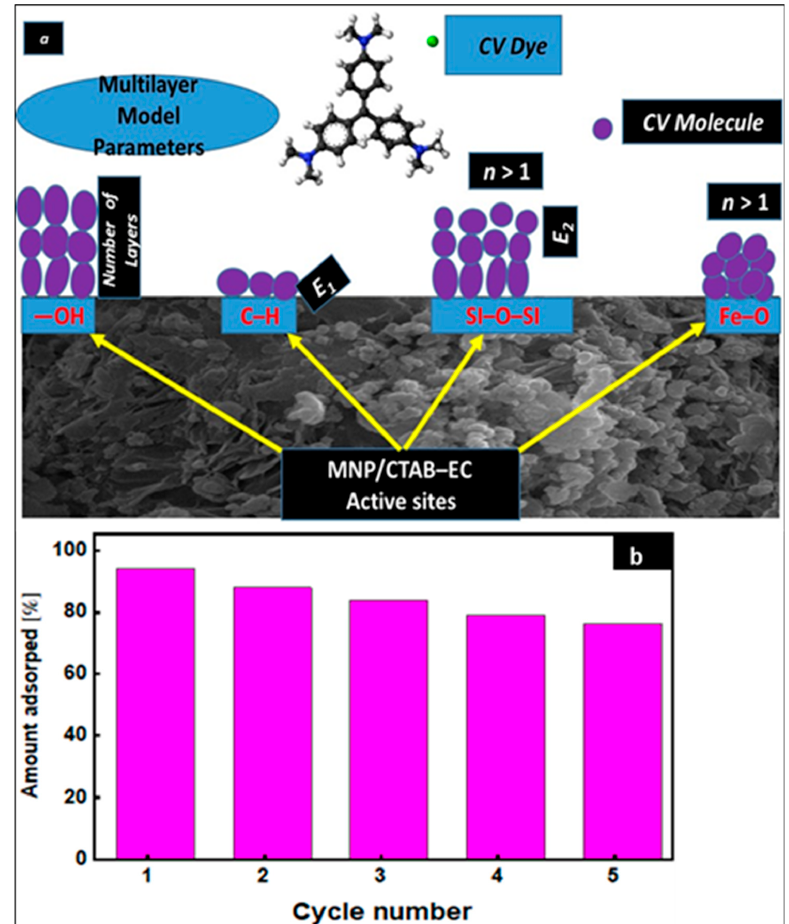
Figure 8. ( a ) Proposal of CV adsorption mechanism based on the steric and energetic parameters of the multilayer model and ( b ) relative uptake percentages after MNP/CTAB–EC regeneration.